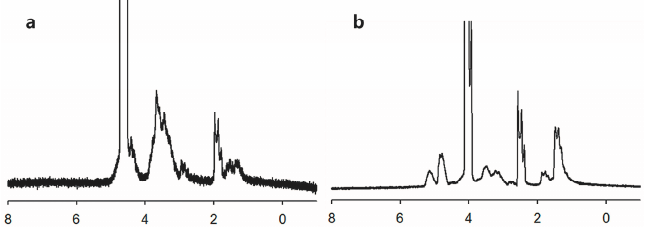
Figure 3. 1 H NMR spectra of core-shell type nanoparticles of HAgLG copolymer in D 2 O ( a ) and DMSO ( b